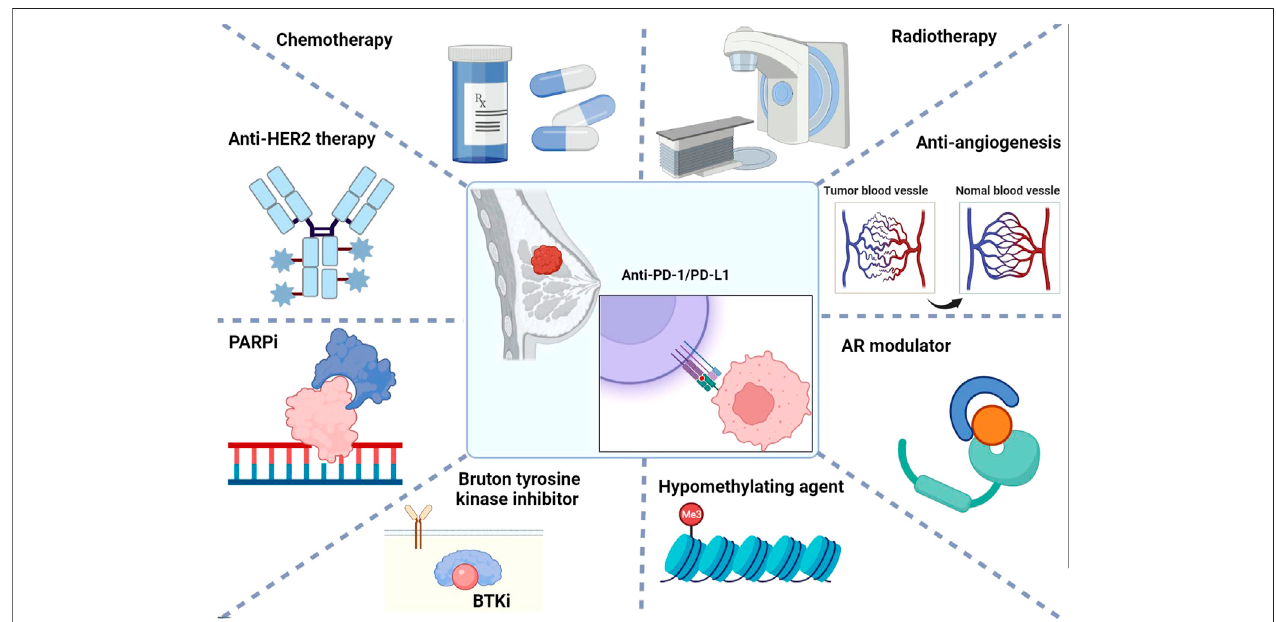
FIGURE 1 | Summary of combinatorial strategies with PD-1/PD-L1 immune checkpoint blockade for breast cancer therapy.